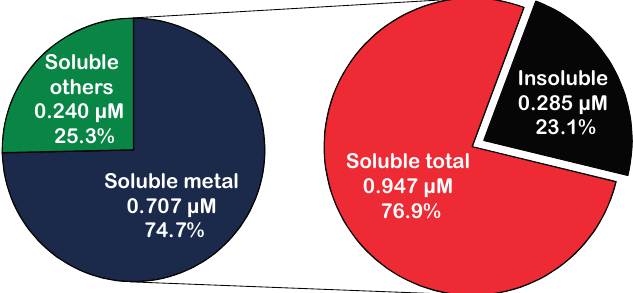
Figure 3. The contribution of different PM fractions on •OH formation. Both